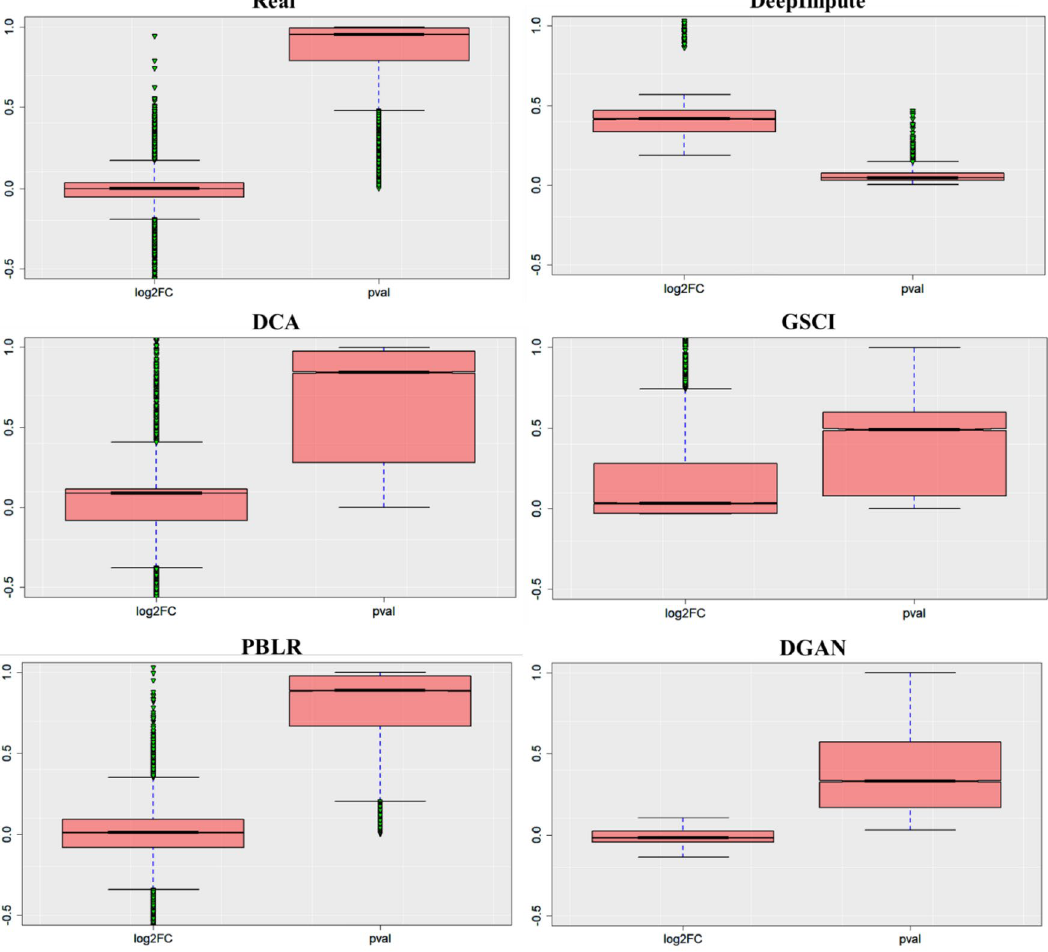
Figure 5. Performance of DGAN on large-scale dataset, whisker plot of gene expression for log2FC and pval by differential expression analysis using PBMC data with different